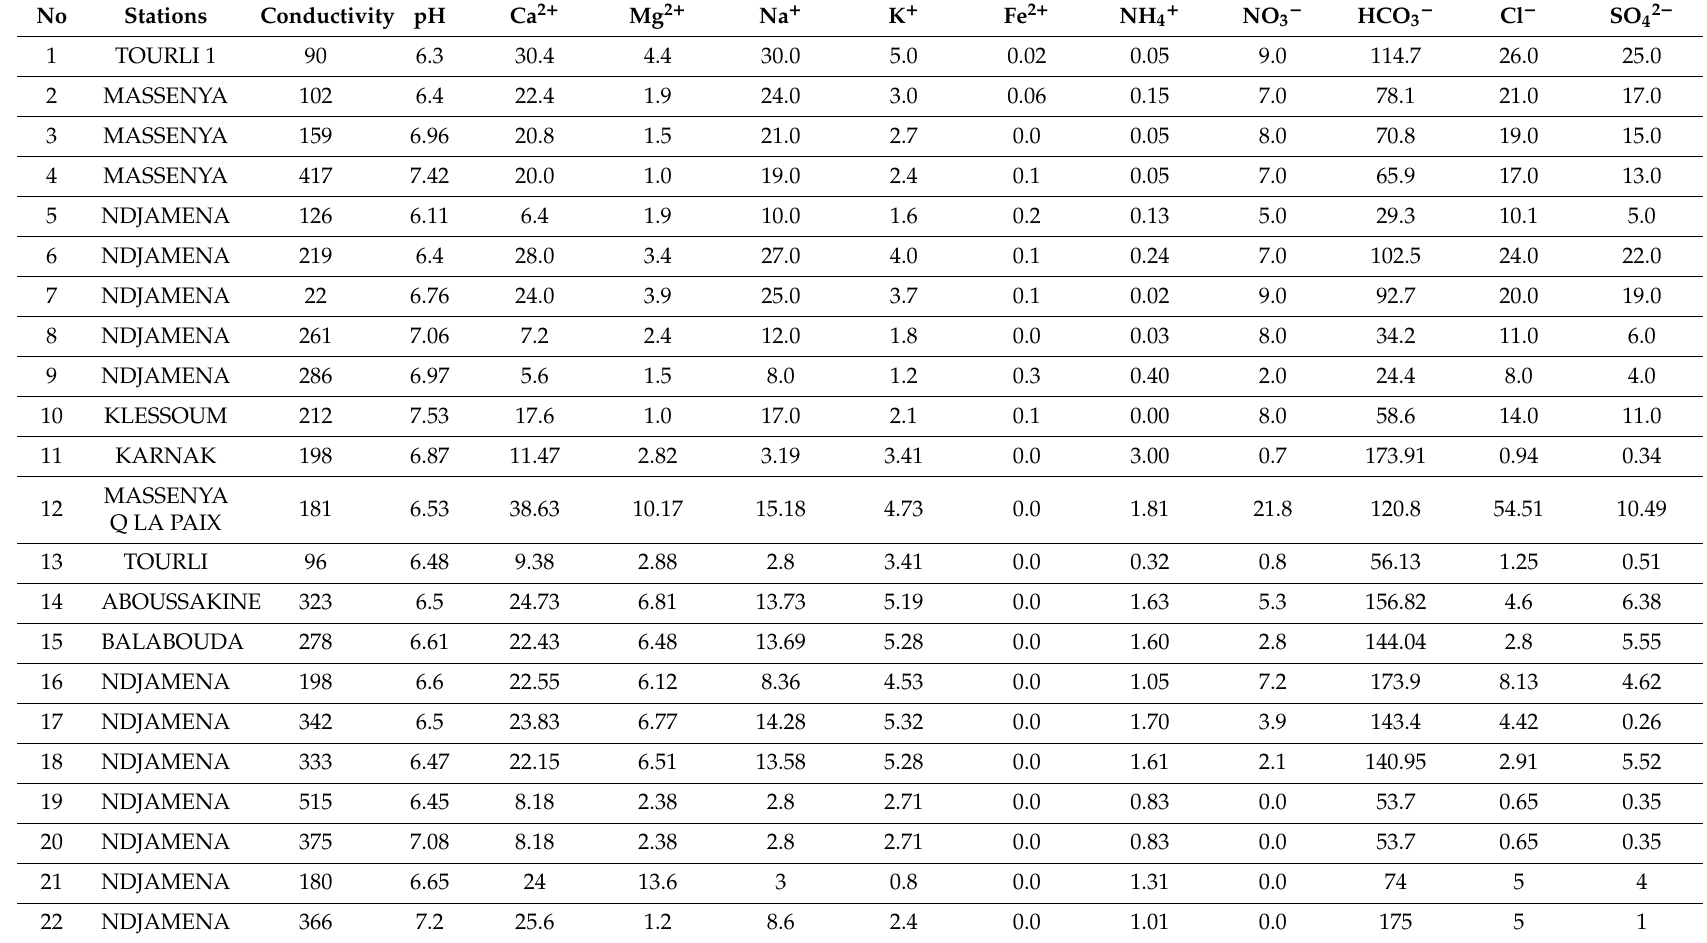
Table 1. Values of the physicochemical parameters of the drilling water